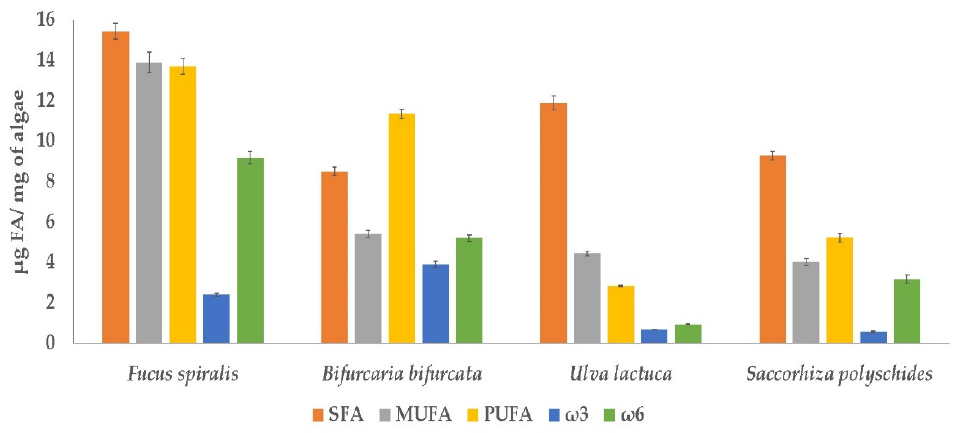
Figure 1. Comparison of the sums of saturated fatty acids (SFA), monounsaturated fatty acids (MUFA), polyunsaturated fatty acids (PUFA), omega-3 ( ω 3), and omega-6 ( ω 6) of Fucus spiralis , Bifurcaria bifurcata , Ulva lactuca, and Saccorhiza polyschides for samples collected in summer, presented as µg of fatty acid/mg of macroalgae. Values are expressed as mean ± SD (n = 3).